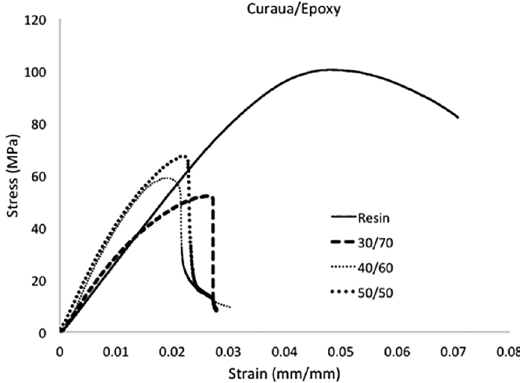
Figure 4. Typical flexural stress vs. strain curves of Curaua/Epoxy composites.